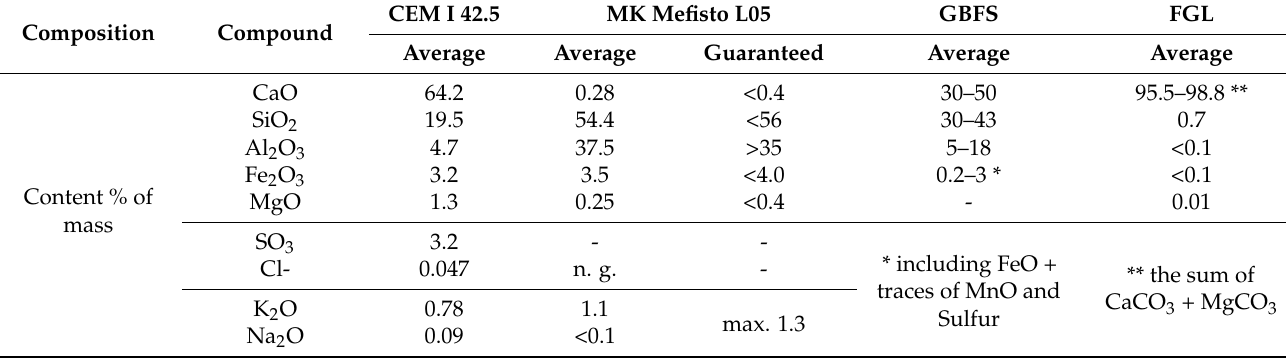
Table 1. Comparison of chemical composition of different powdered binders used in the described tests. CEM I 42.5 MK Mefisto Composition Compound